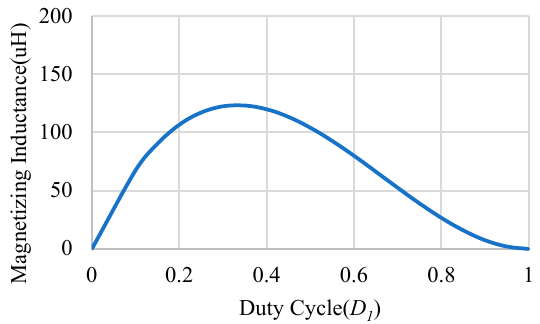
Figure 9. L m1, BCM in the step-up mode.